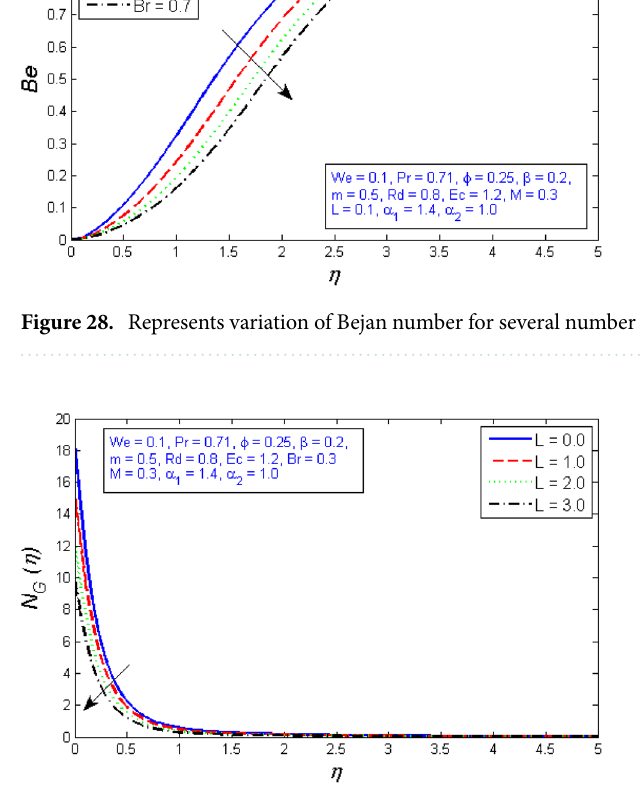
Figure 29. Represents variation of Entropy generation for several number of diffusion parameter L .